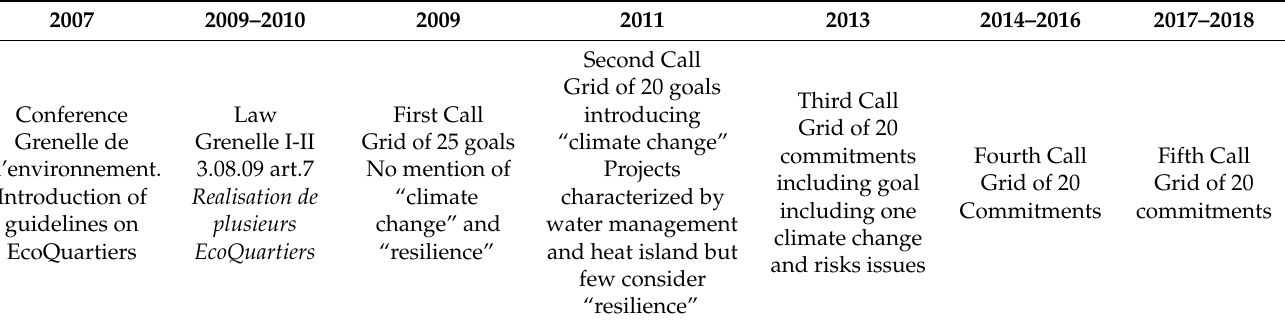
Table 3. Environmental topics in the evolution of the Laws Grenelle and Calls EcoQuartiers. Source: Authors’ elaboration from literature review